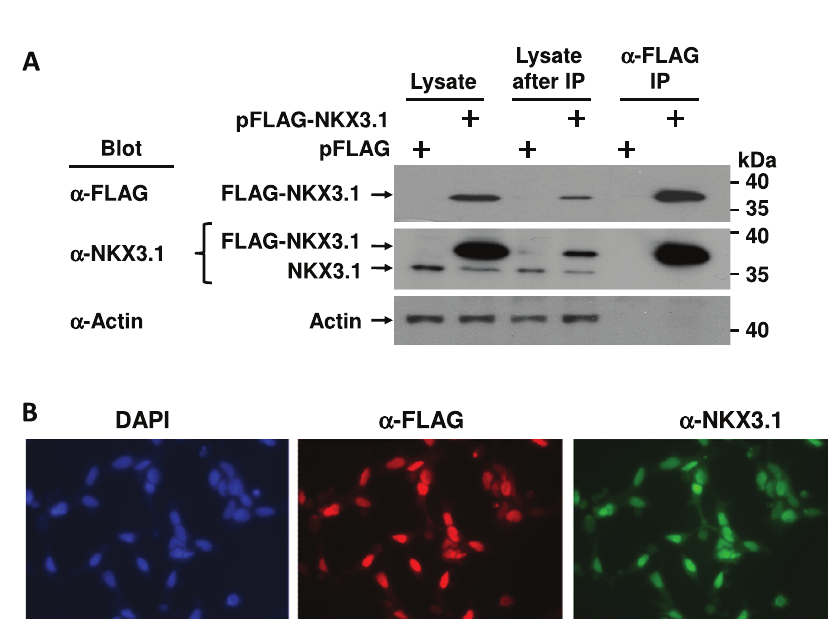
Figure S1. Transfection of FLAG-NKX3.1 expression into LNCaP cells and affinity purification. ( A ) LNCaP cells were transfected with pFLAG-NKX3.1 plasmid or with the empty pFLAG vector. Total cell lysate (lanes 1 and 2) was absorbed to anti-FLAG resin and eluted with FLAG peptides (lanes 5 and 6). The depleted cell lysate after affinity purification is shown in lanes 3 and 4. Immunoblots were probed with the indicated antibodies. The blot with NKX3.1 shows the overexpressed FLAG-NKX3.1 and the endogenous NKX3.1 protein (middle panel). Actin was used as loading reference. Cropped blot images are shown; see Figure S9 for full images. ( B ) LNCaP cells were transfected with pFLAG-NKX3.1 plasmid, and FLAG-NKX3.1 was detected by indirect immunofluorescence staining with FLAG or NKX3.1